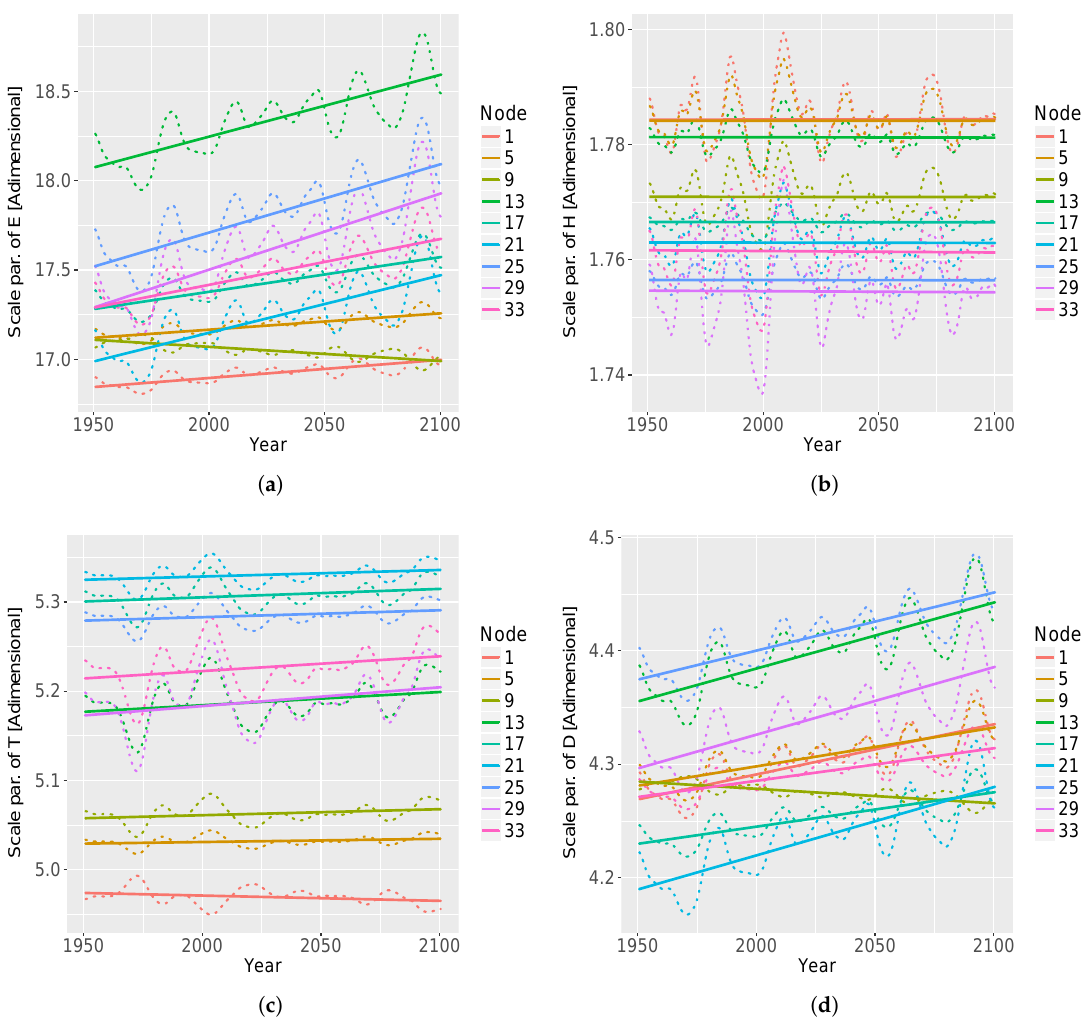
Figure 5. Scale-parameter β of the GPD that models ( a ) E , ( b ) H p , ( c ) T p , and ( d ) D at selected nodes, under the RCP4.5 scenario. The EA was used in the VGAM to predict the scale parameter β of H p and D . The first time-derivative of EA was used in the VGAM to predict the scale parameter β of T p . The scale parameter β of E is not affected by the selected climate indices. The time series are approximated by a straight line, which helps to see the trend of the scale parameter β in each